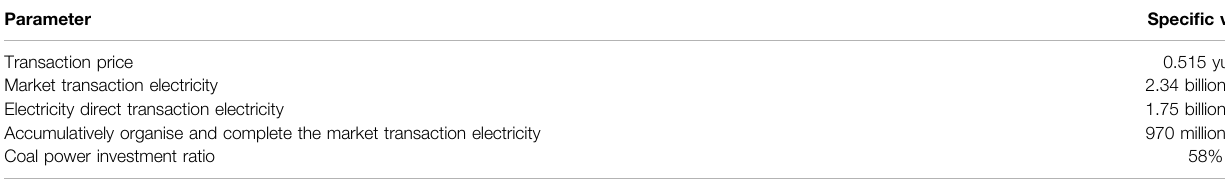
TABLE 1 | Descriptive statistical results of relevant information of electric power enterprises. Parameter